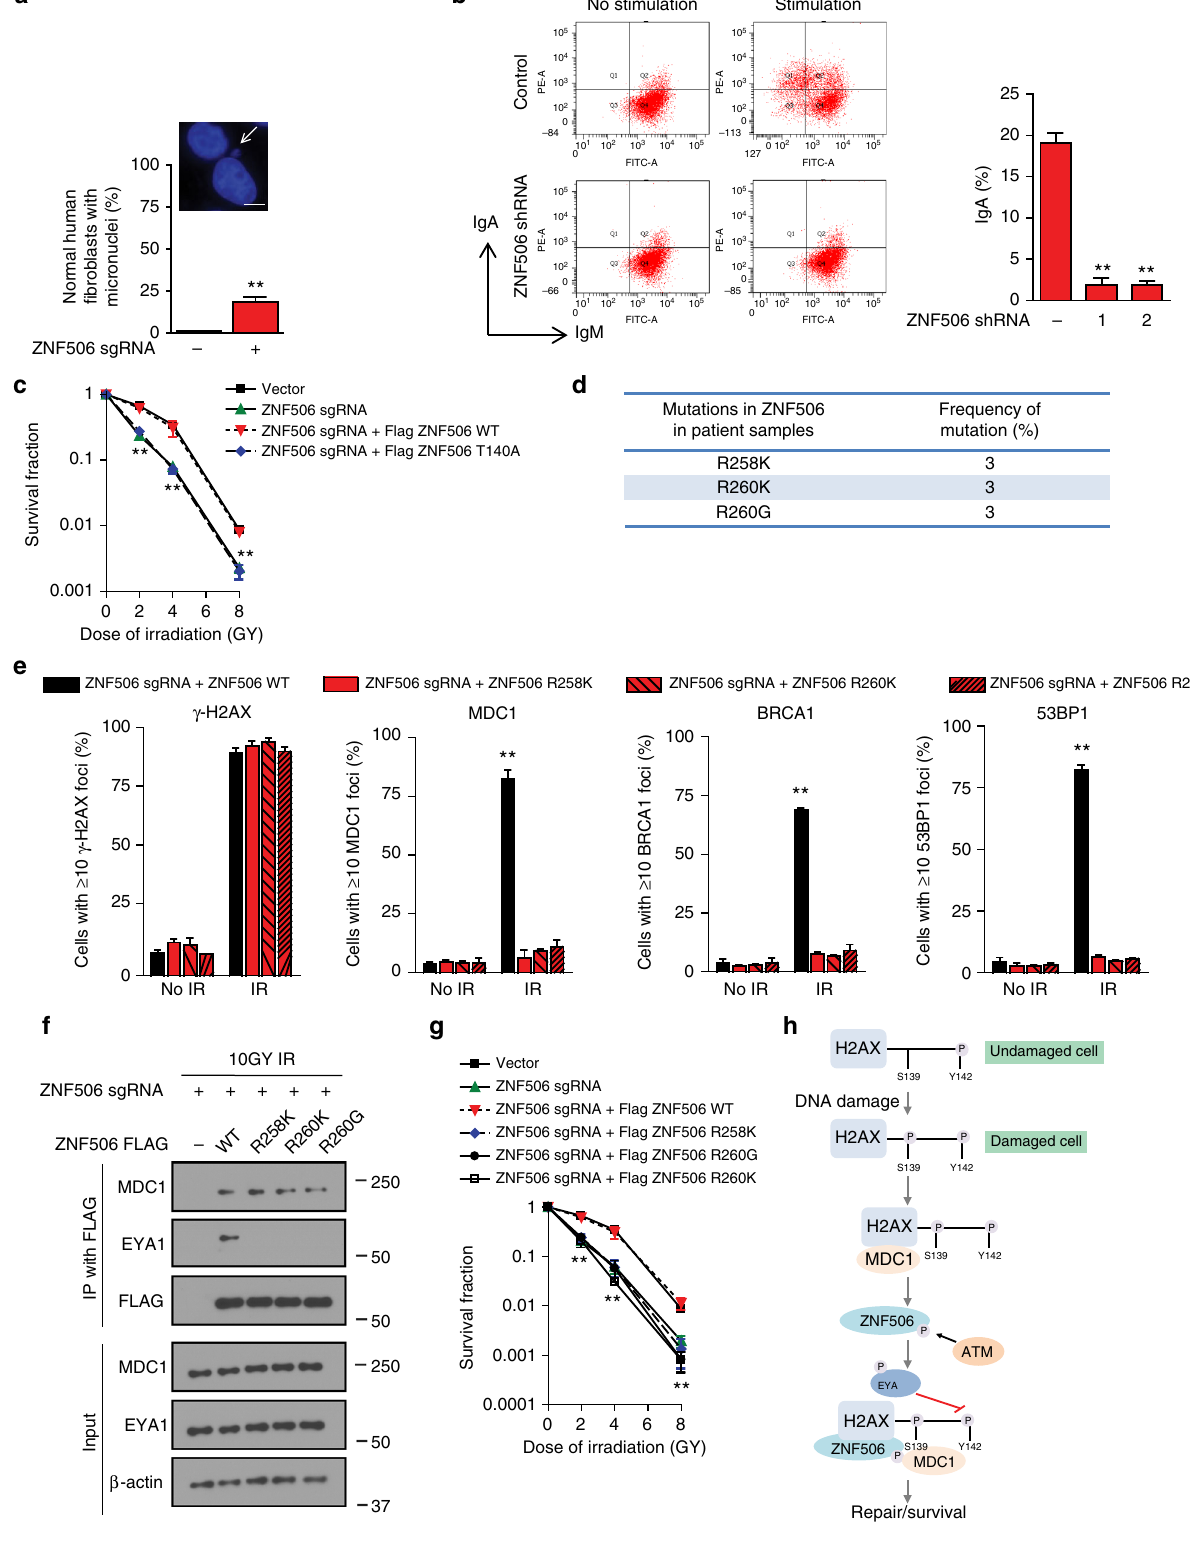
Fig. 4d – g, the initial formation of γ -H2AX was unaffected by these mutations. However, foci formation of MDC1 and down- stream repair proteins were drastically reduced. In U2OS cells knocked out for ZNF506 and subsequently reconstituted with either wild-type or the phosphorylation mutant (T140A), as